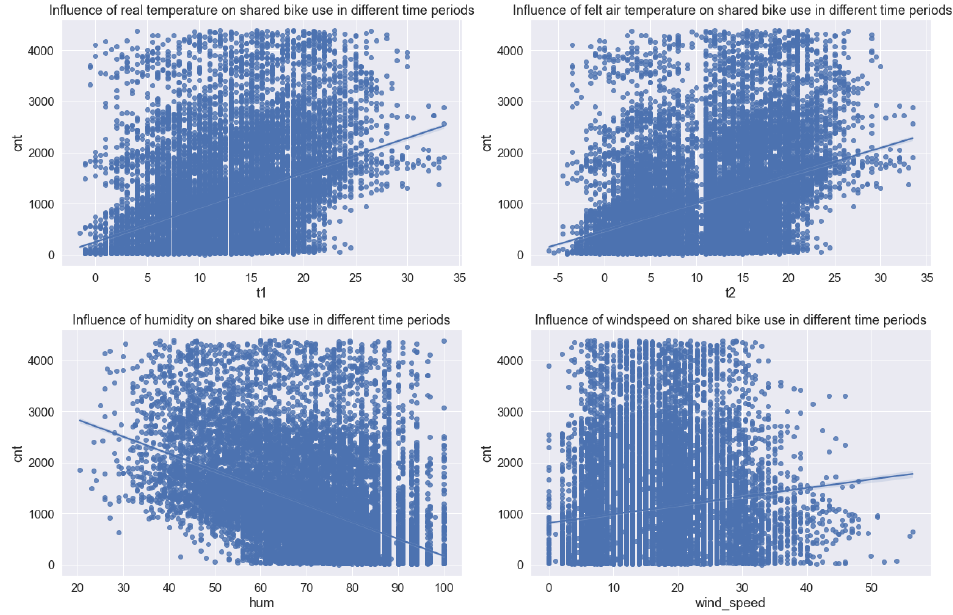
Figure 4. The influence of meteorological factors on the short-time demand of shared